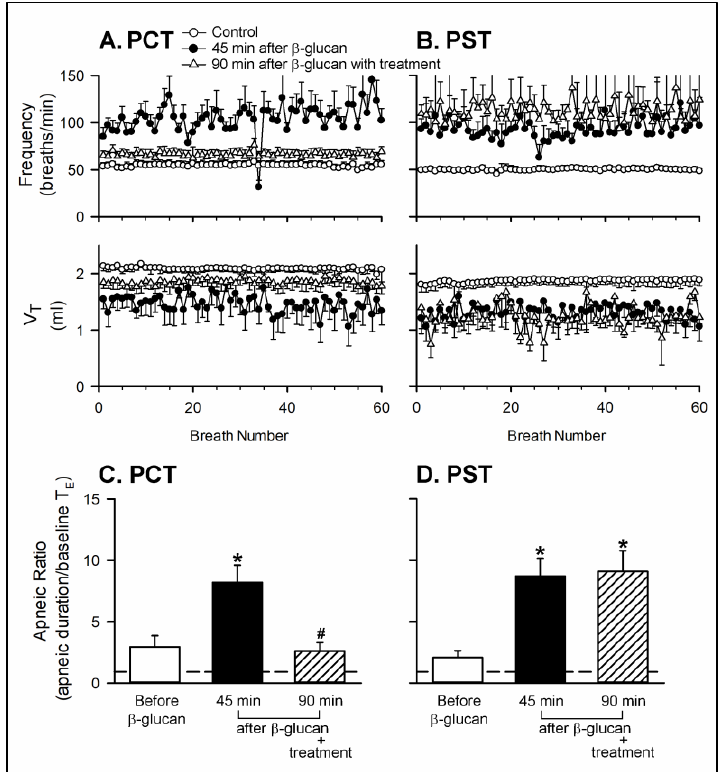
Figure 3. E ff ects of perineural capsaicin treatment (PCT) and perineural sham treatment (PST) on the enhancing e ff ects of the intratracheal instillation of β -glucan on the baseline breathing pattern and apneic response to right-atrial injection of capsaicin in two groups of anesthetized, spontaneously breathing rats. ( A , B ): e ff ects of PCT and PST on the intratracheal instillation of β -glucan on the baseline frequency and V T , respectively; ( C , D ): e ff ects of PCT and PST on the intratracheal instillation of β -glucan on the apneic responses to capsaicin injection, respectively. Data are means ± SE ( n = 6). One-way ANOVA followed by Newman-Keuls post hoc test: *, significantly di ff erent from before β -glucan ( p < 0.05); # , significant di ff erence when corresponding data between without and with treatment were compared ( p < 0.05). Please note that the β -glucan-induced sensitization was blocked by PCT, but not altered by